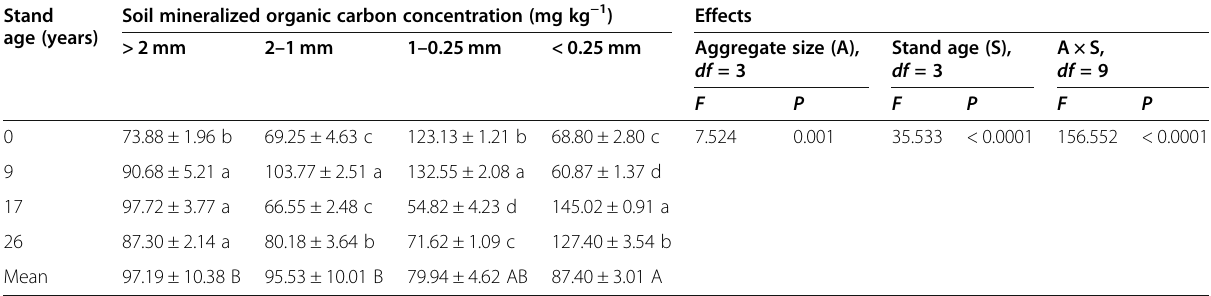
Table 8 Effects of aggregate sizes (> 2, 2 – 1, 1 – 0.25, and < 0.25 mm) and stand ages (0, 9, 17, and 26 years) on the soil mineralized organic carbon concentration in a chronosequence of Chinese fir plantations Stand Soil mineralized organic carbon concentration (mg kg − 1 age (years)